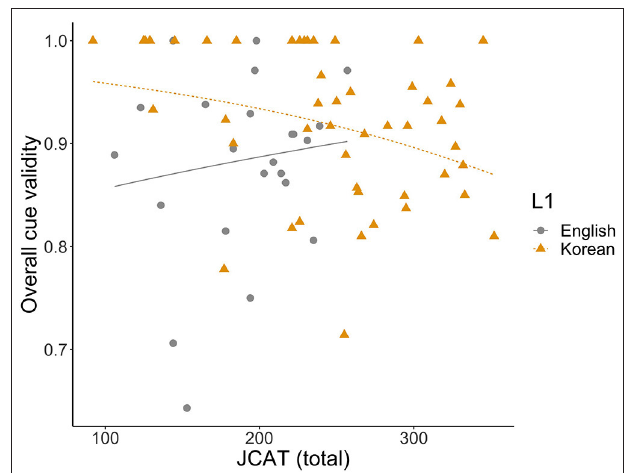
FIGURE 2 | Overall cue validity (calculated for individual participants) of animacy as a function of JCAT scores with logistic regression fit; the lines represent the predicted validity for JCAT scores 106–257 for L1-English learners (solid line) and 92–352 for L1-Korean learners (dotted line).